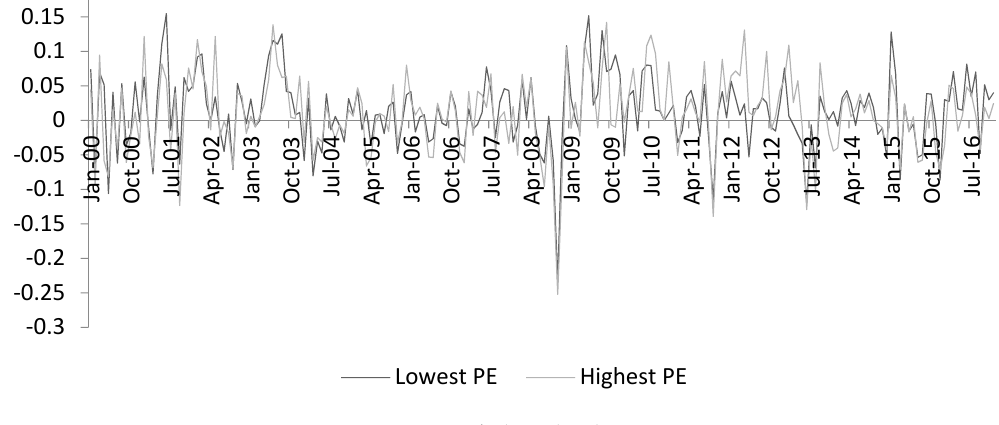
Figure 2. P/E based indexes. Table 5. Correlation between P/E based indexes